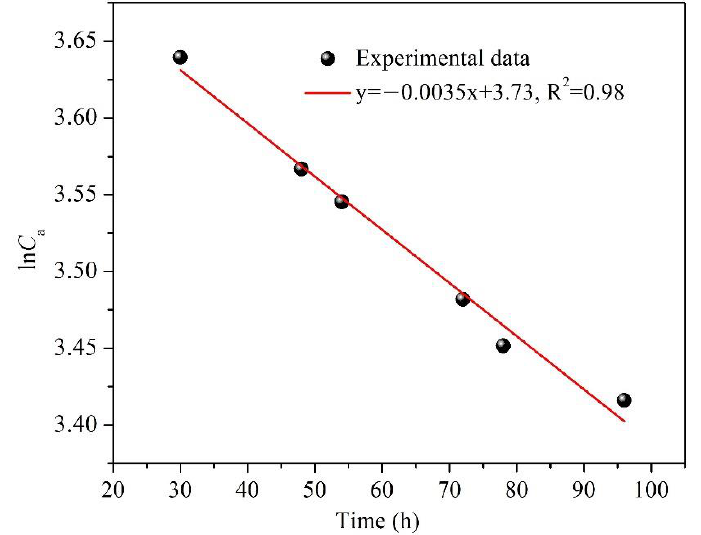
Figure 6. Linear curve fitting results by applying Equation (7) to treat the experimental